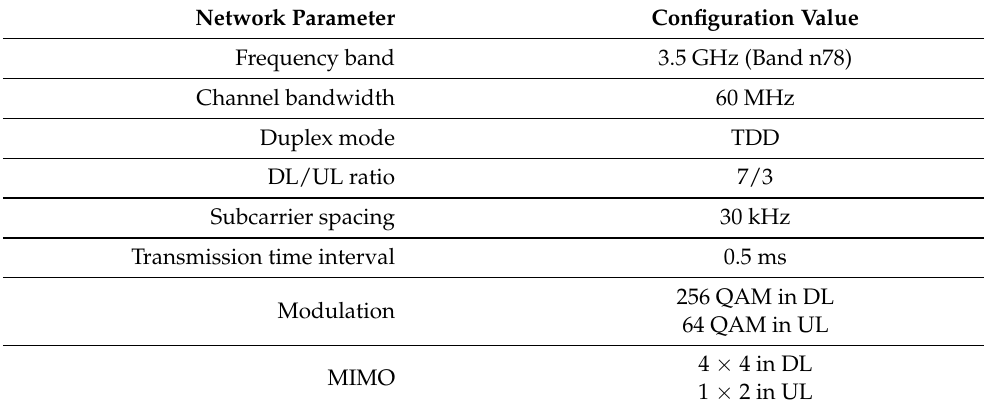
Figure 6. The 5G test facility architecture with estimated backhaul and fronthaul link distances. Table 3. 5G test facility RAN